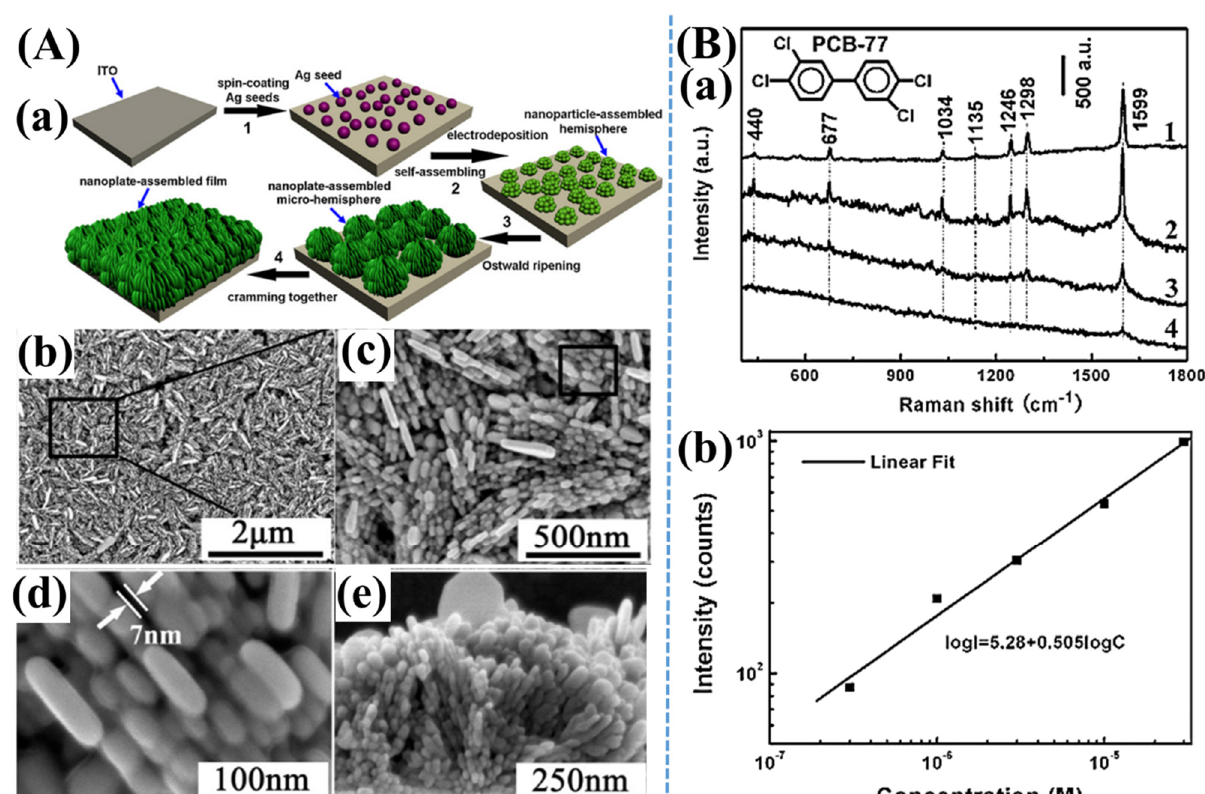
Figure 3. ( A – a ) Schematic diagram of sensitive SERS detection of 3,3 ′ ,4,4 ′ -tetrachlorobiphenyl (PCB-77) based on the fabrication of vertically-aligned silver nanoplates assembled on indium tin oxide (ITO) substrates. SEM images of the Ag nanoplate-based SERS substrate at different scales including ( A – b ) 2 µm and ( A – c ) 500 nm. ( A – d ) SEM image shows a magnified view of the black color rectangular region marked in ( A – c ). ( A – e ) Side-view SEM image of the Ag nanoplate- based SERS platform. ( B – a ) Raman spectra of (1) pure PCB-77 powder, SERS spectra of PCB-77 with different concentrations of (2) 10 − 4 M, (3) 3 × 10 − 6 M, and (4) 3 × 10 − 7 M, respectively, using Ag nanoplate-assembled substrates. All Raman spectra were acquired with an acquisition time of 60 s. ( B – b ) Using Ag nanoplate-based SERS platform, a linear curve has been obtained for the logarithmic values for the intensities at 1599 cm − 1 correlated with the concentrations of PCB-77. Adapted from [47].